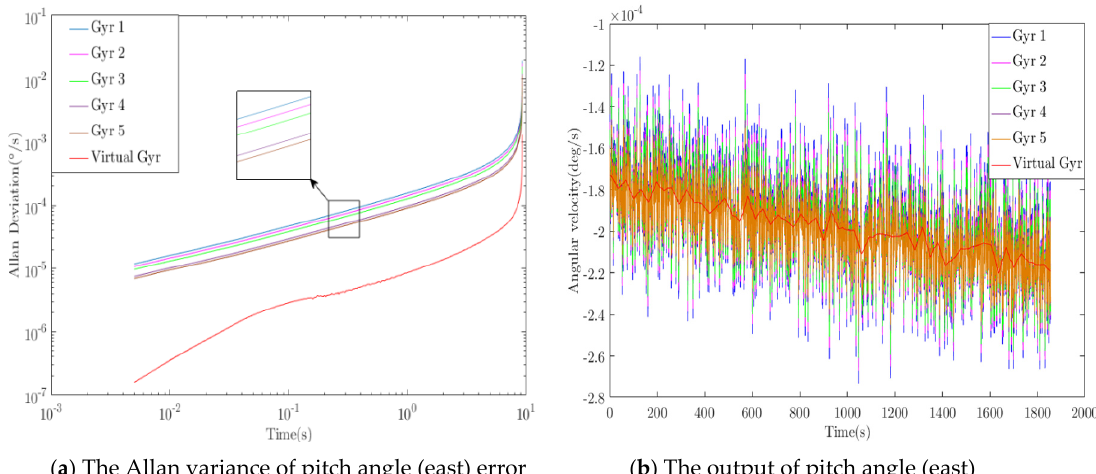
Figure 5. Optimization results of pitch angle (east) error.